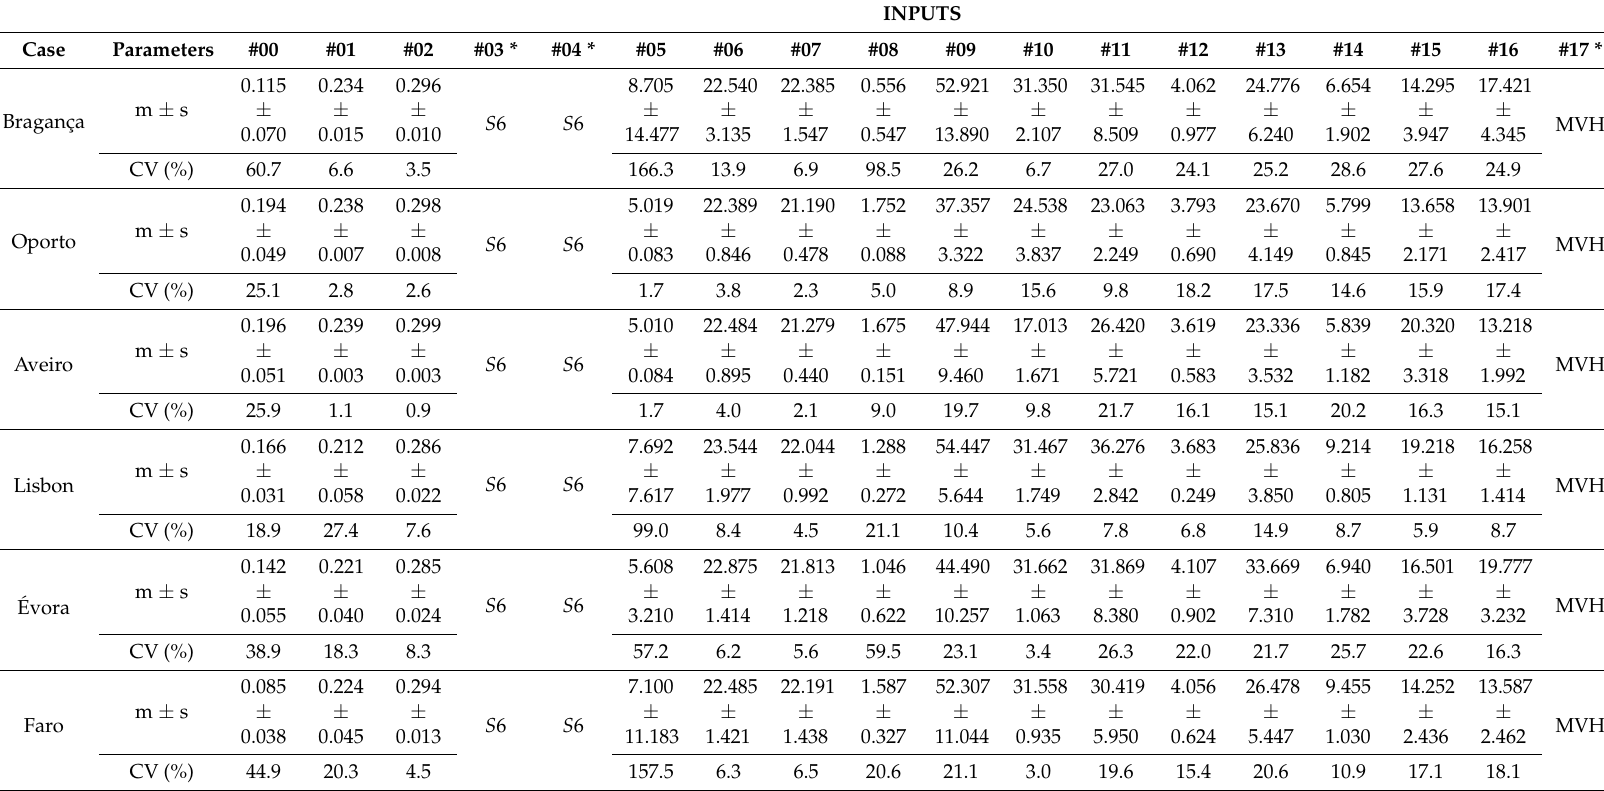
Table 7. Statistical analysis of